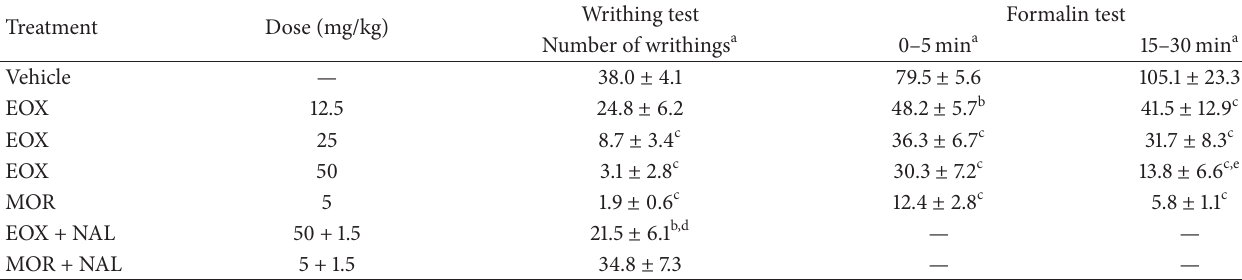
Table 3: Effect of X. laevigata leaf essential oil (EOX) or morphine (MOR), in the absence and presence of naloxone (NAL), on writhing induced by acetic acid and formalin-induced nociception tests in mice.